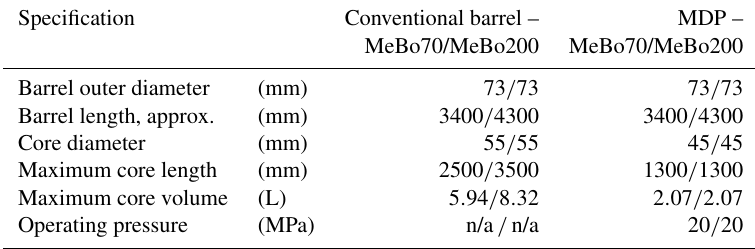
Table 1. Specifications of the conventional core barrels and the MDP operated with MeBo70 or